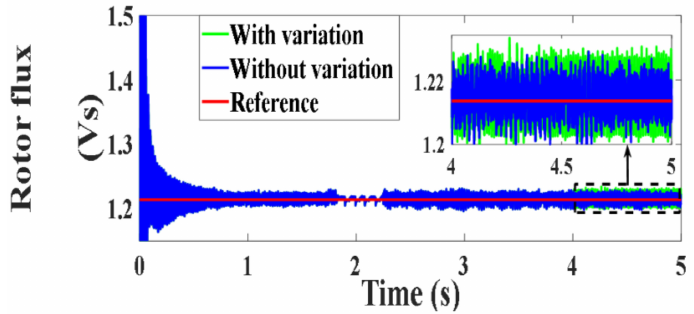
Figure 106. Rotor flux under PVC (Vs).